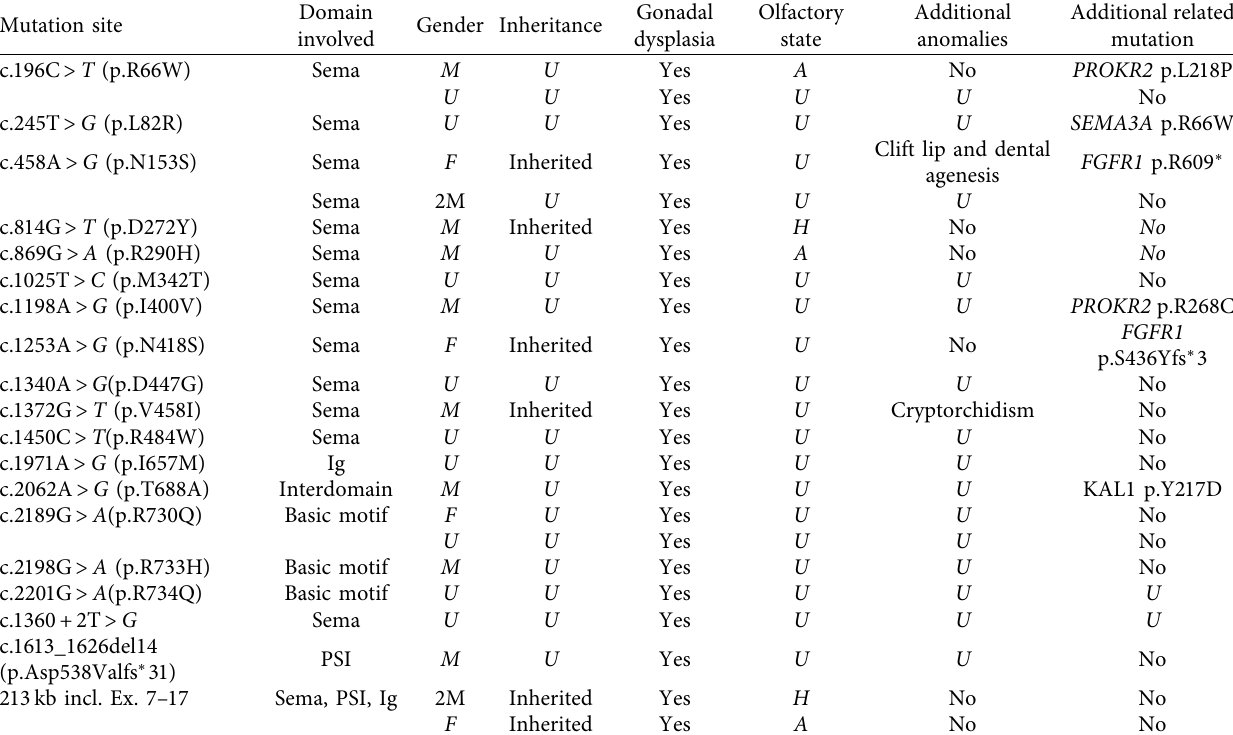
Figure 3: Defective expression of the mutant SEMA3A proteins in vitro . (a) The intracellular SEMA3A production of COS-7 cells transfected with the pcDNA3.1-SEMA3A-Mu decreased by about 30% compared with that of cells transfected with pcDNA3.1-SEMA3A- WTthrough western blot. Since SEMA3A was also slightly expressed in kidney cells, the EV group also showed a low level of expression. (b) The ELISA results showed that the protein level of the mutant SEMA3A in the condition medium from COS-7 cells was significantly lower than that of the wild-type SEMA3A by about 80%. Each experiment was carried out at least three times independently. A repeated-measure ANOVA followed by Bonferroni post hoc tests or unpaired two-tail Student’s t -test was used. ∗∗ P < .01. EV: empty vector; WT: wild-type; Mu: variant. Table 2: All SEMA3A variants reported associated with Kallmann